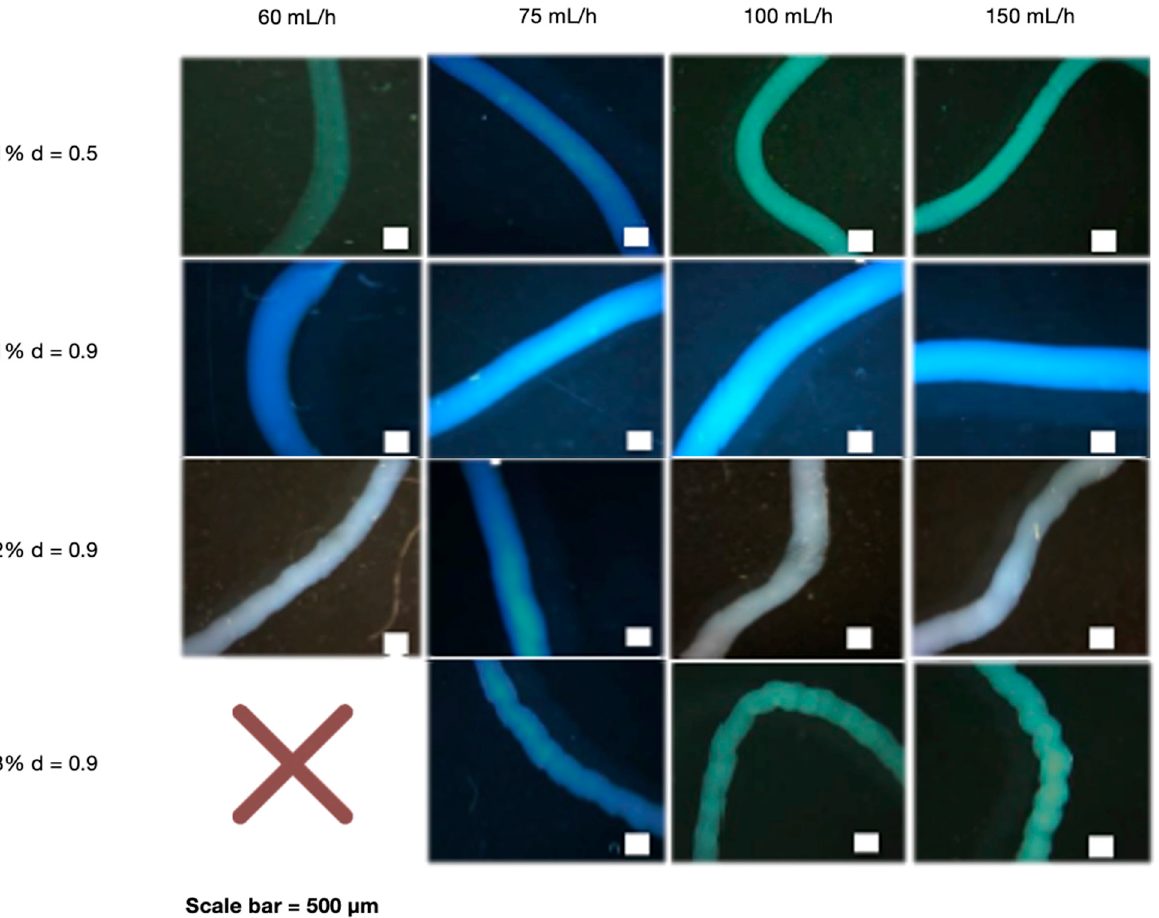
Figure 1. Optical microscope images of CS fibers at different percentages (1, 2 and 3%) and at different rates (60, 75, 100 and 150 mL/h). CS fibers at 1% were manufactured with 0.5- and 0.9-mm needle diameter, and the rest of fibers with 0.9-mm needle diameter. The NaOH solution was 0.5 M. Scale bar 500 µm.